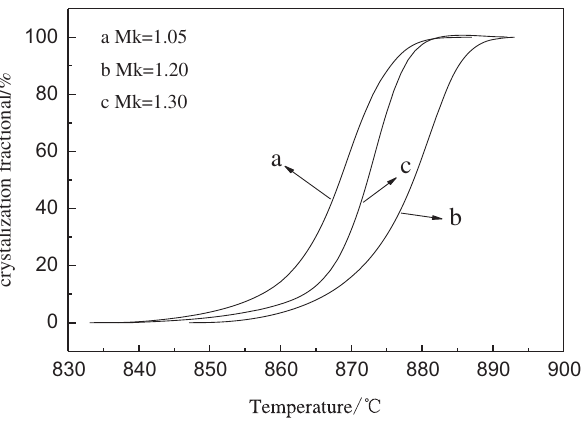
Figure 8: Effect of acidity coefficient on the fractional crystallization.